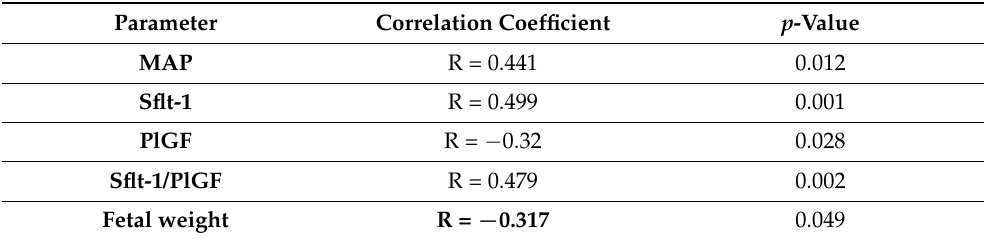
Table 5. Analysis of the correlations between uric acid levels and the evaluated parameters within the group with neonates below the 3rd PC.